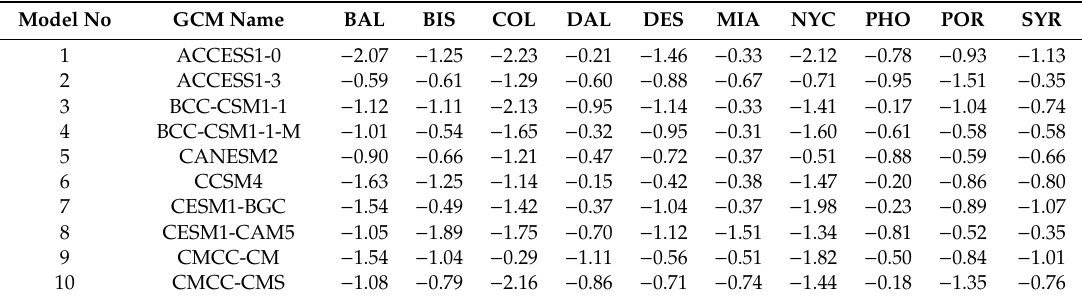
Table A10. NSE coe ffi cient of Night between observed and simulated data (1950–2005). Model